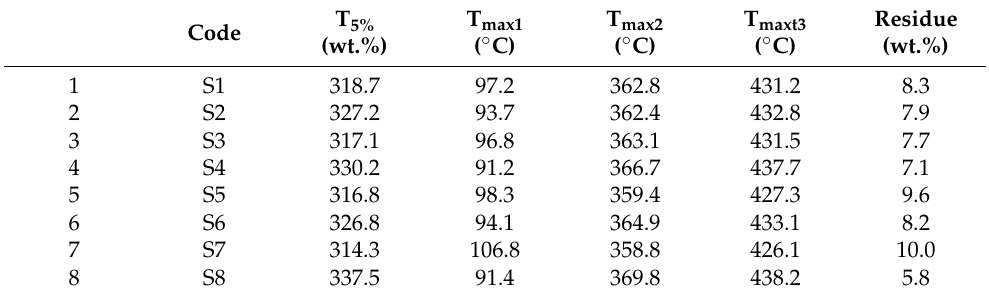
Table 3. The transition temperature at 5% weight loss (T 5% ), initial degradation temperature (T max1 ), major degradation temperature (T max2 ), final degradation temperature (T max3 ), and residue of lami- nated